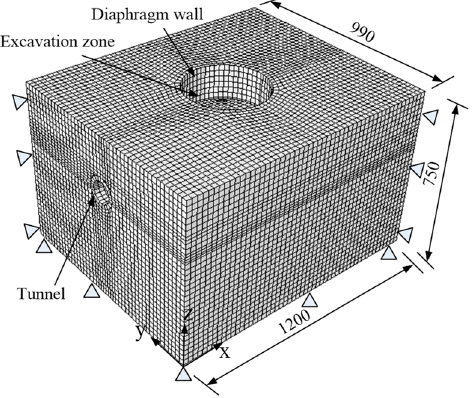
Figure 2. Finite element model (in model scale, unit: mm).